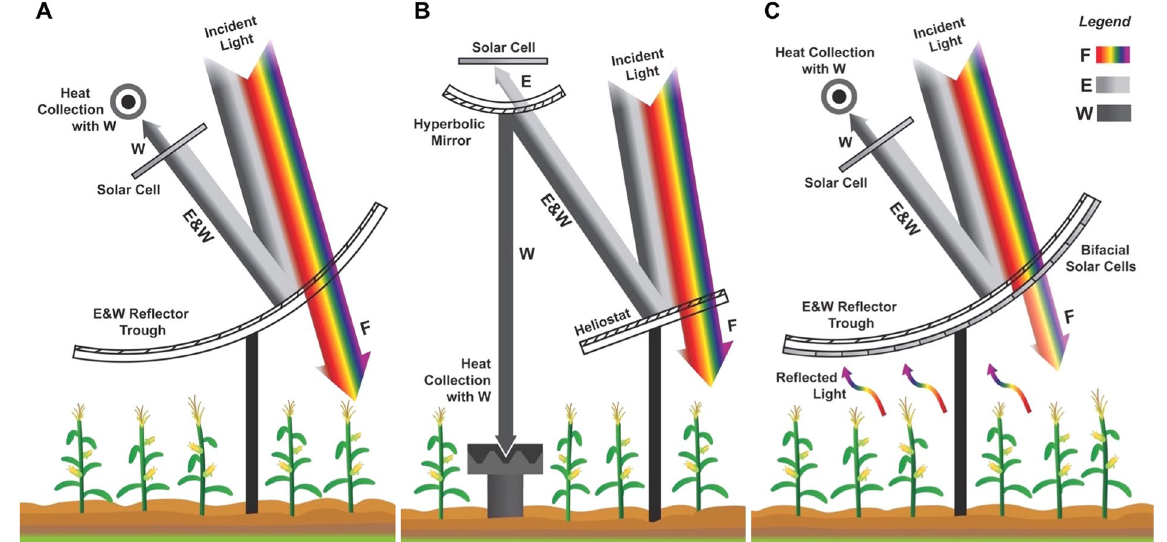
Figure 2. Illustration of the solar photons unbundling concept for solar photons through three alternative arrangements: ( A ) A parabolic trough with a reflective surface that transmits full intensity F (scenario A) for plant growth and reflects E&W. The solar cell absorbs E and transmits W for heat collection to purify water by multistage flash or multieffect distillation. ( B ) A heliostat with the same reflective surface as in A, but W is reflected off of a hyperbolic mirror to a heat cavity before E is incident on solar cells. ( C ) For plants that can thrive in a reduced intensity of F (scenario B), the same arrangement as A, but a thin bifacial solar cell is used under the reflective surface to harness a portion of F for electricity generation and any reflected light from underneath the trough. (Figure credit: Ryan Ellis, Purdue